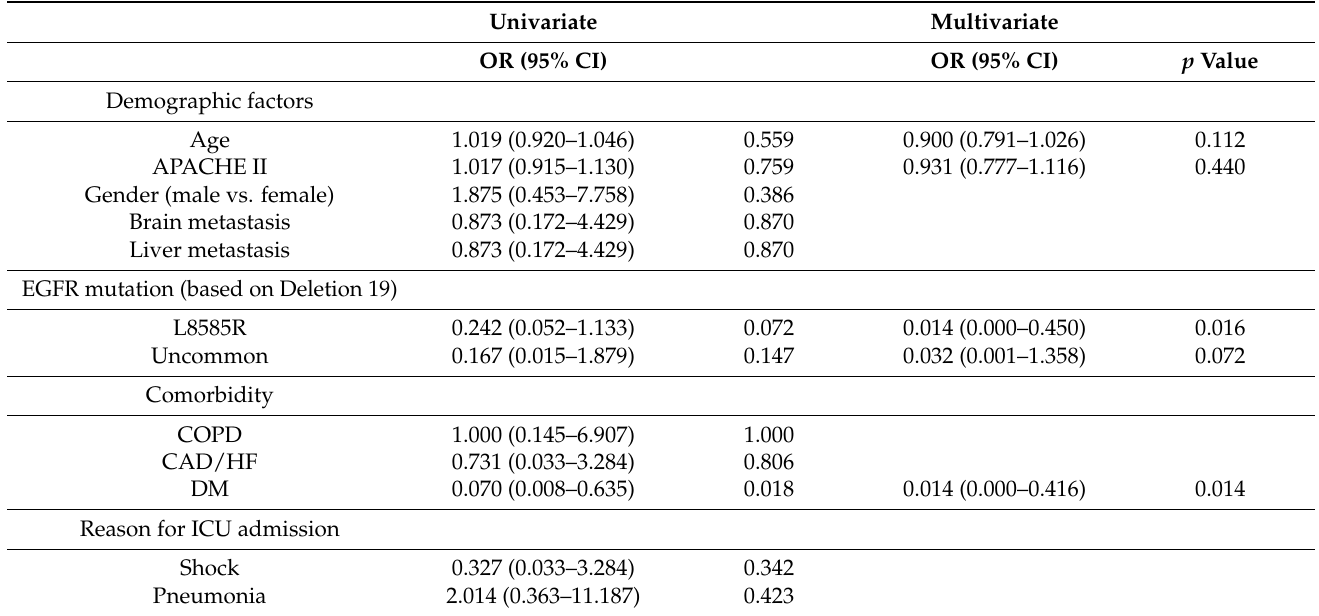
Table 3. Univariate and multivariate analysis of clinical factors associated with successful MV weaning. Univariate Multivariate OR (95% CI) OR (95%